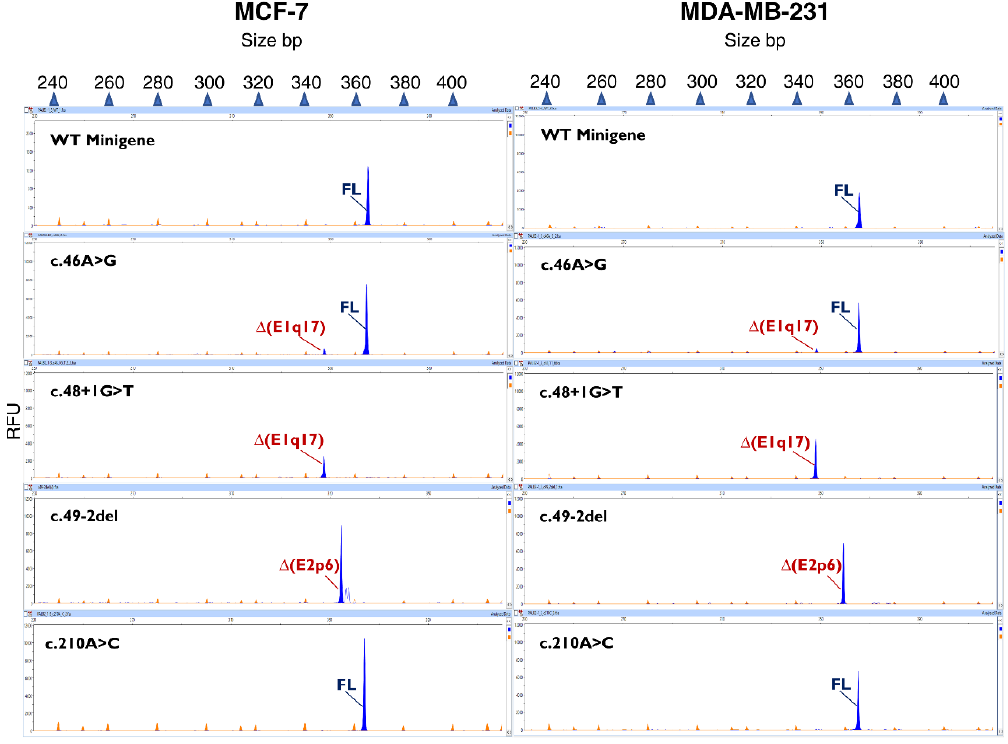
Figure 2. Reproducibility of PALB2 RNA assays in MDA-MB-231 (left) and MCF-7 (right) cells. The wild-type and mutant minigenes of c.46A > G, c.48 + 1G > T, c.49-2del, and c.210A > C were tested in MCF-7 and MDA-MB-231 cells. RT-PCR products were run by fluorescent fragment electrophoresis using LIZ-600 as size standard. The x-axis indicates size in bp (electropherograms on the top) and the y-axis represents relative fluorescence units (RFU).